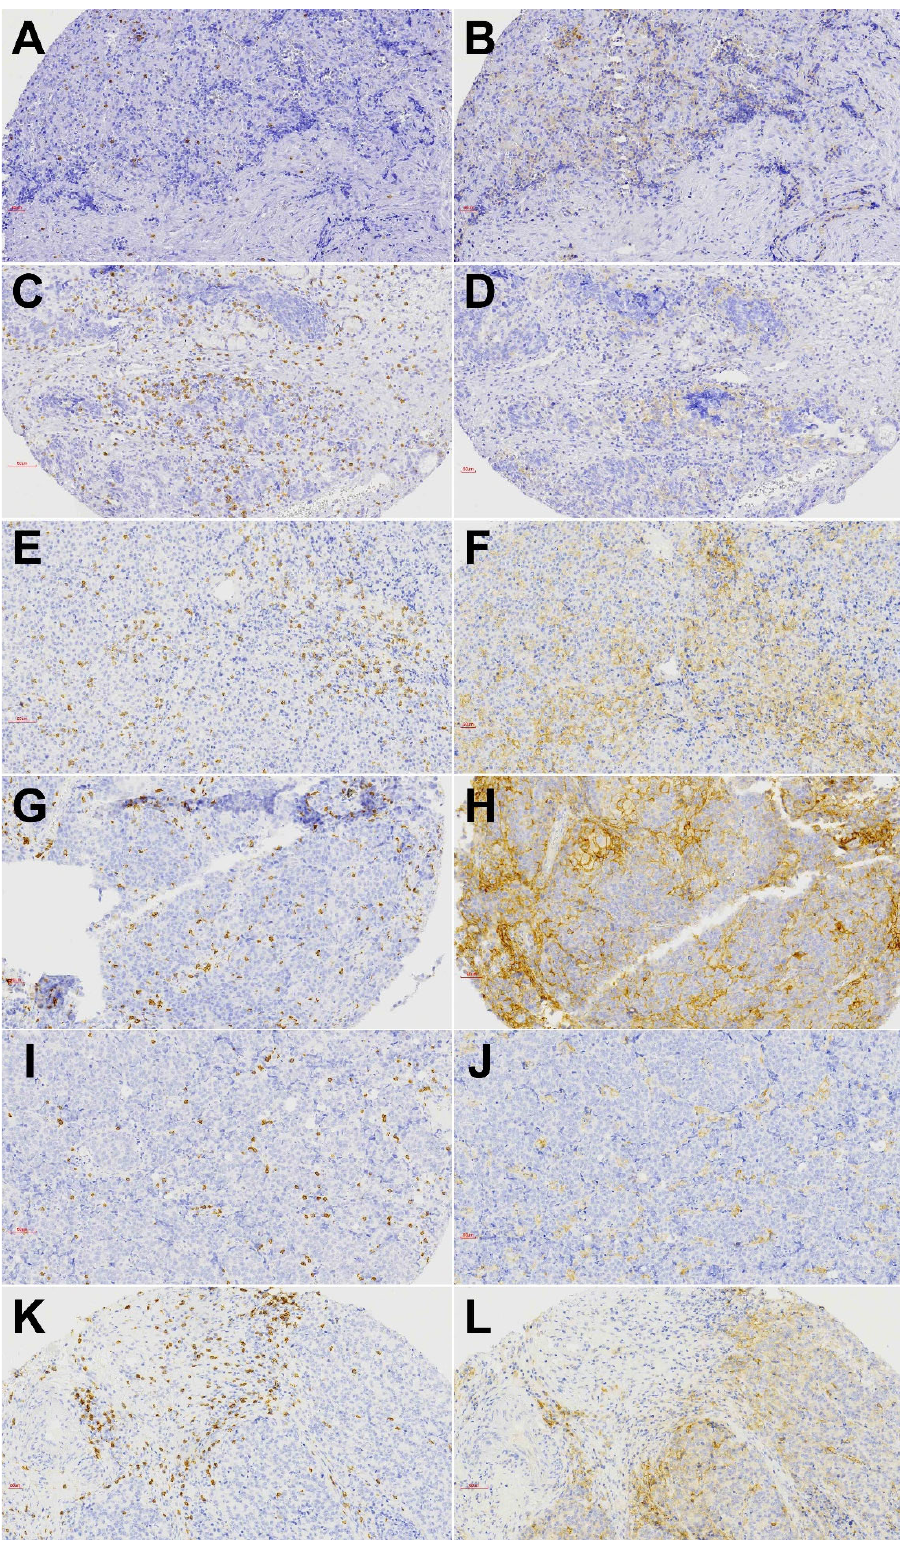
Figure 3. Immunohistochemical staining of CD8+ TILs and PD ‐ L1 ‐ expressing tumor cells of tumor subtypes ONB ( A , B ), SNEC ( C , D ), SNUC ( E , F ), PD ‐ SNSCC ( G , H ) HG ‐ non ‐ ITAC ( I , J ) and solid ‐ type ITAC ( K , L ). Left column: CD8+ TILs and right column: PD ‐ L1 expression. All images ×200 magnifi ‐ cation.